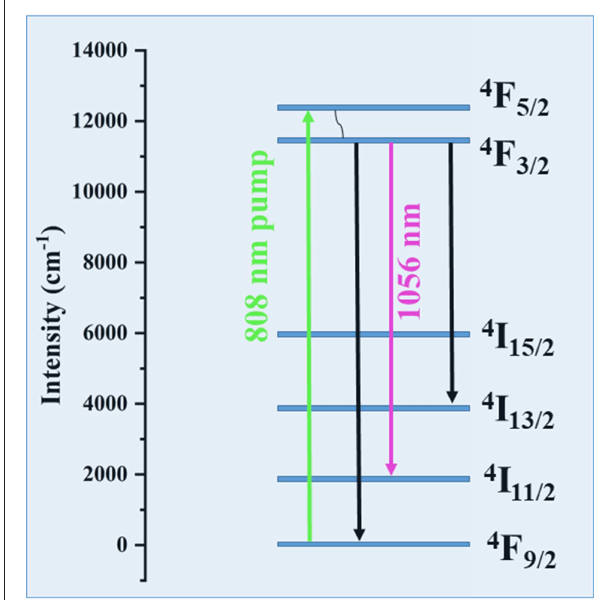
FIGURE 2 | Schematic energy level and related transitions of the near-infrared photoluminescence emission processes.